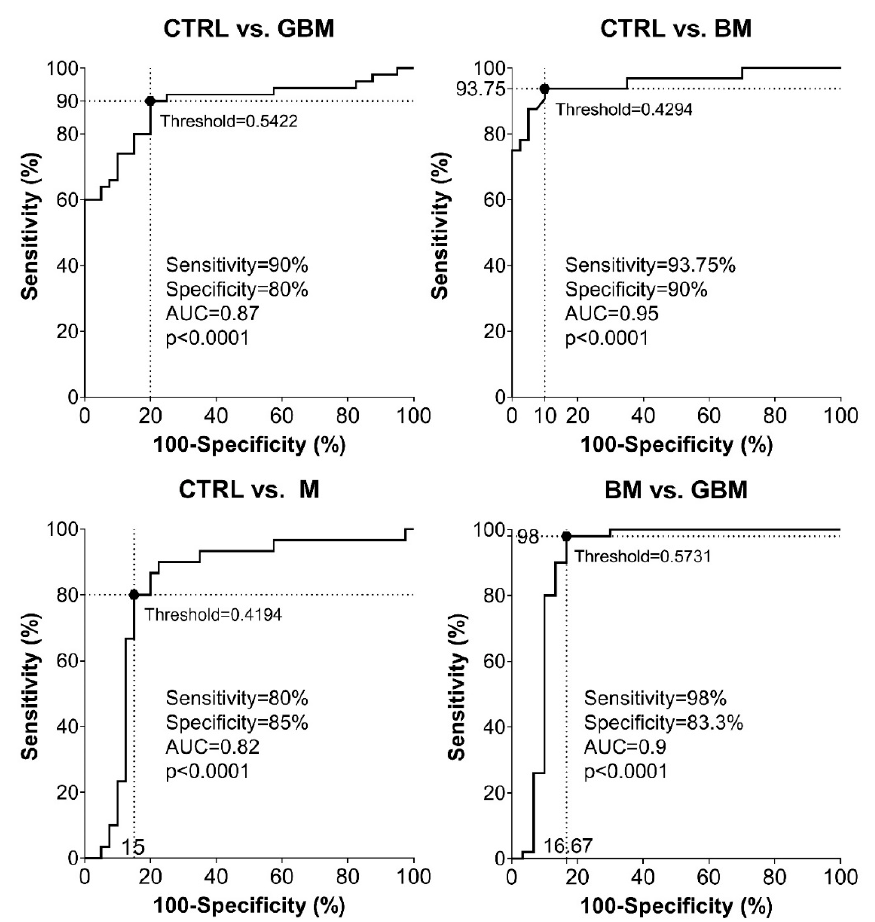
Figure 5. Receiver Operating Characteristic (ROC) curves for the classification models. Intersecting black dotted lines show sensitivity, specificity and corresponding threshold values of the group-membership score, with black filled circles at their intersections.